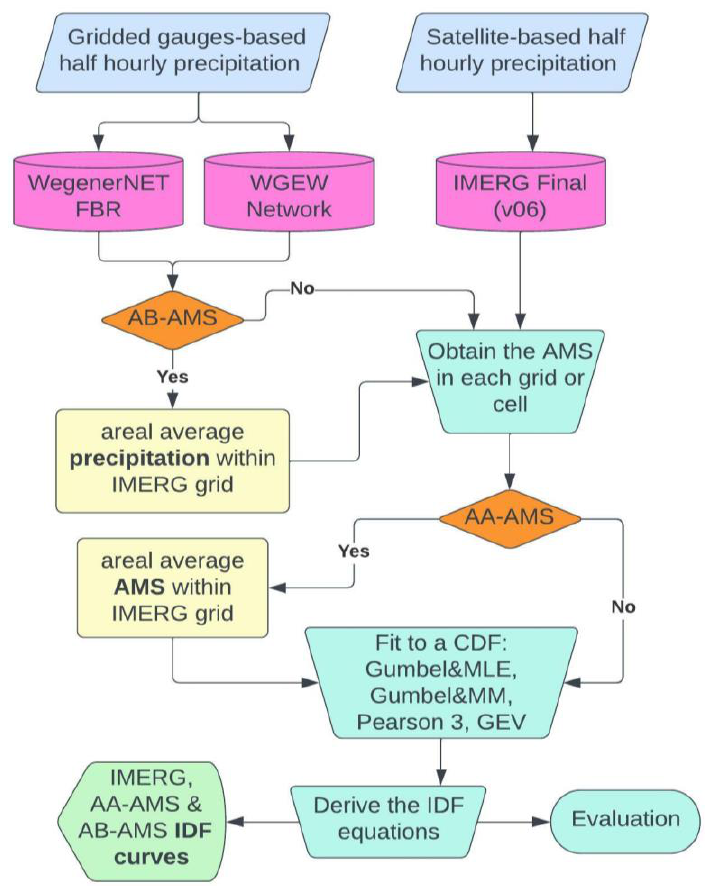
Figure 2. Study Figure 2. Study workflow .